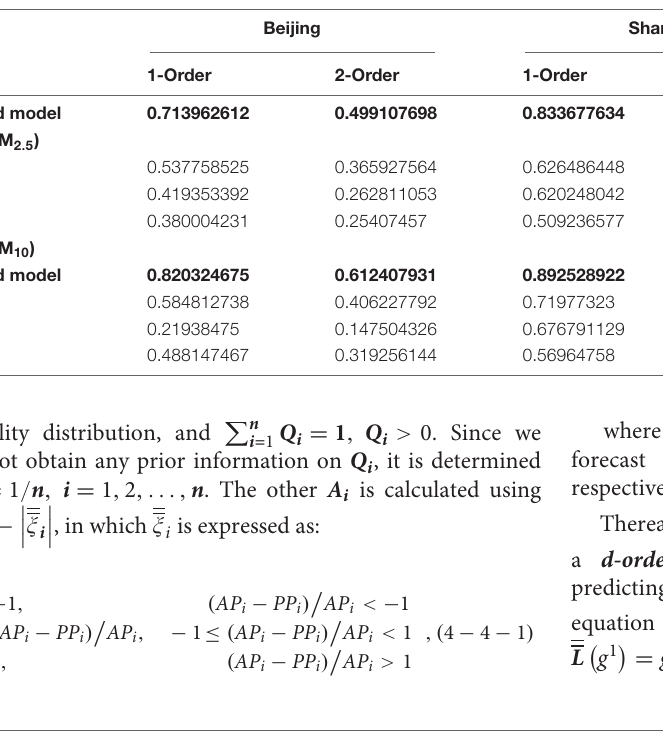
TABLE 9 | Forecasting effectiveness (FE) of different models (PM 2 . 5